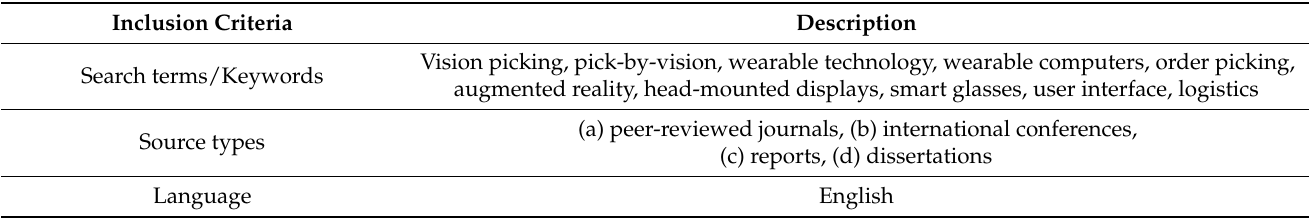
Table 2. Inclusion criteria for implementing SLR